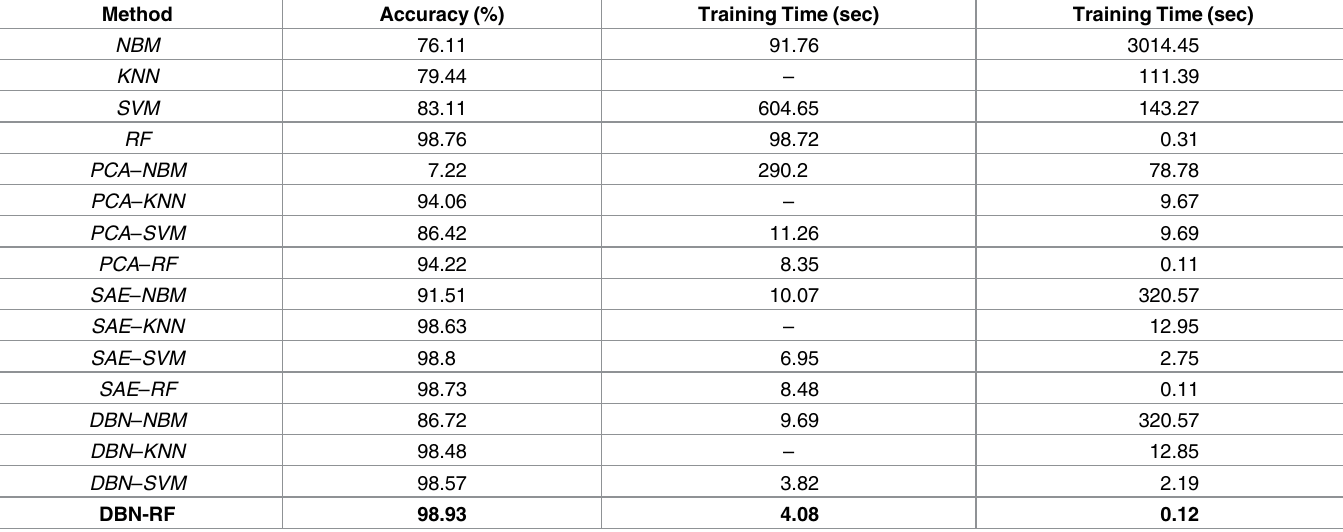
Table 2. Comparison of the training time and forecasting accuracy(training 30%, testing 70%).